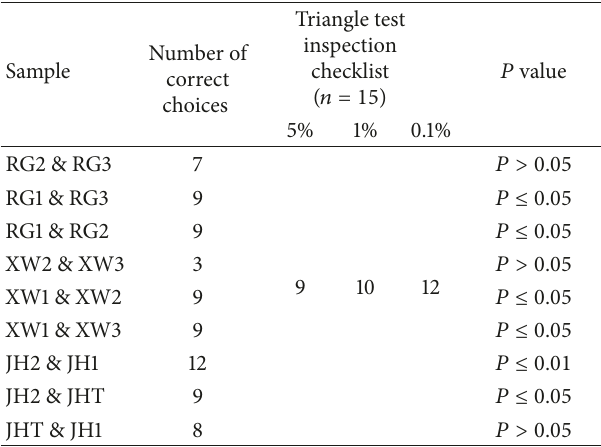
The abbreviations in the table are referred to in Grades of Ham Samples and Their